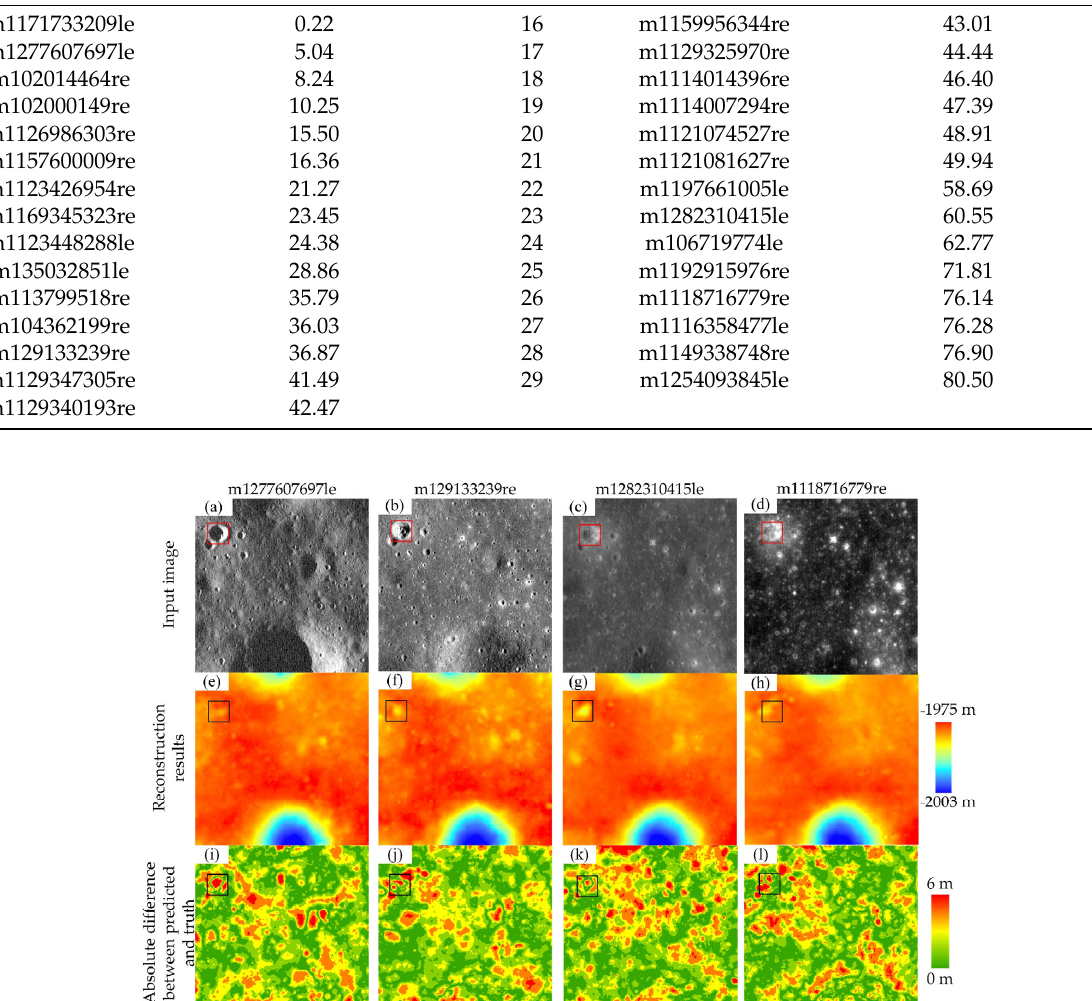
shown in Figure 8a, m127760767le, solar altitude angle 5.04°), the RMSE of the marked region is 5.88 m. When the image brightness (gray scale value) of the region is close to 0, the reconstruction network could be unable to translate much effective information from